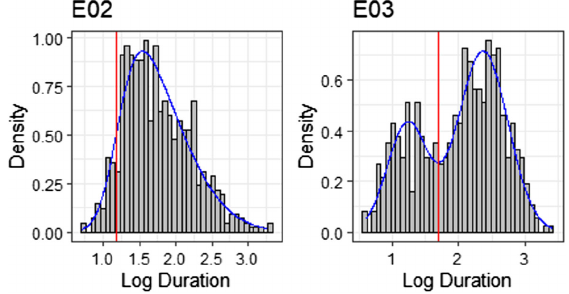
FIG. 4. Histogram and best FMM fit profile for log attempt duration (base 10) of modules E02 (1-component skewed normal) and E03 (two-component normal). Red line indicates the cutoff for short attempts estimated from the FMM fit.